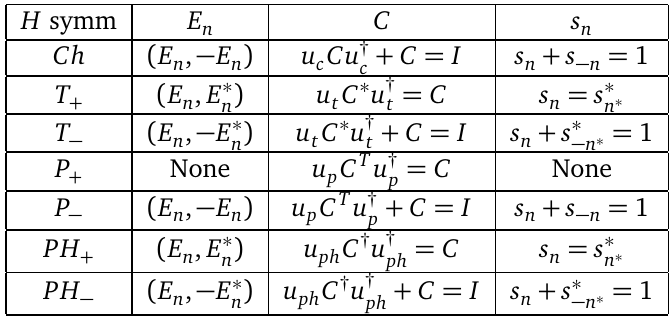
Table 1: The symmetry conditions for both the Hamiltonian and the two-site correla- tion matrix. The first column is the symmetry verified by the Hamiltonian. The sec- ) means that energies ond column marks how energies appear in pairs (e.g., ( E , − E n n appear in pairs of opposite signs). The third column is the symmetry transformation obeyed by the correlation matrix, while the fourth summarizes the corresponding conditions on the occupancy numbers of the many-body state. The table can be in- terpreted in two ways. Starting from a symmetric Hamiltonian, the fourth column indicates the constraints on the occupancy numbers of the many-body state such that the entanglement Hamiltonian also admits the same symmetries. Conversely, starting from a Gaussian state with a symmetric H , the third column indicates the E symmetries verified by the correlation